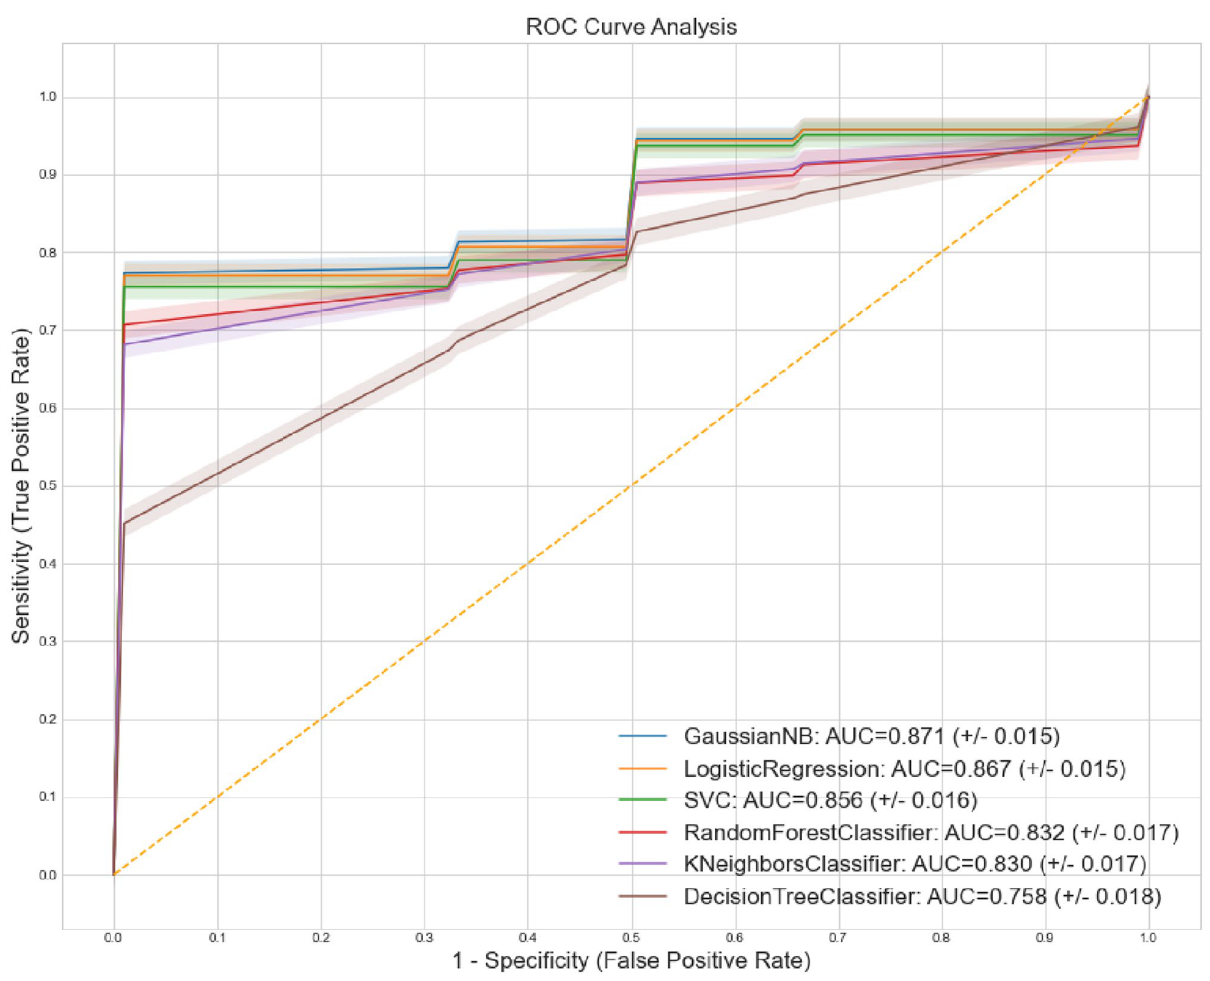
Figure 8. Nested CV ROC analysis of binary ROC Analysis. Figure 8 illustrates the ROC curves for all binary machine learning classifiers tested using ten- fold nested CV. Discussion